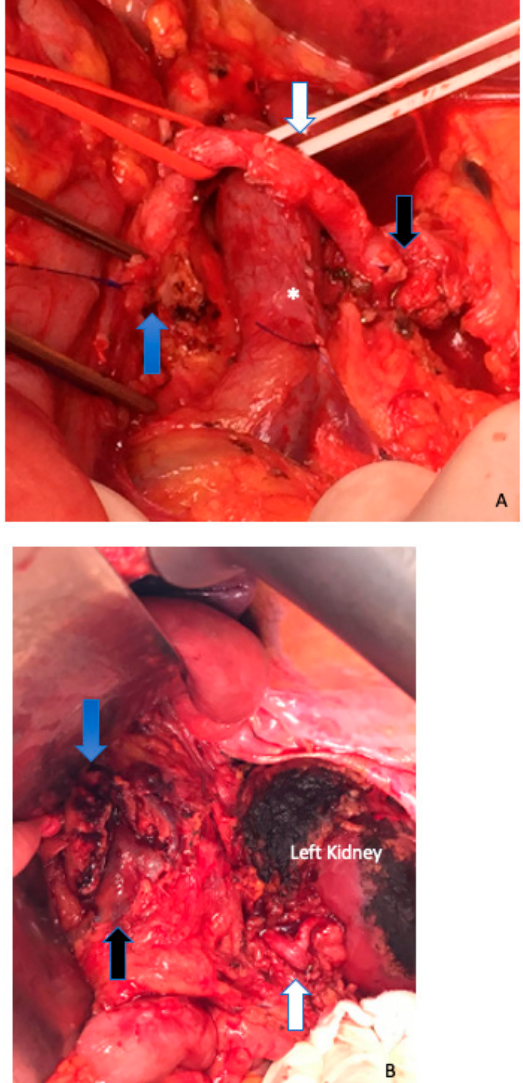
Figure 4. ( A ) Radical antegrade modular pancreatosplenectomy (RAMPS) proceeds in a right-to-left antegrade manner, with early parenchymal transection at the neck of the pancreas, close to the gastroduodenal artery (blue arrow) and early control of the splenic vessels (in its origin) (white arrow). The black arrow marks the common hepatic artery, and the asterisk shows a partial venous excision spleno–mesenteric confluence with direct closure (venorrhaphy). ( B ) Posterior RAMPS. The posterior magnitude of dissection was behind the left adrenal gland, including the Gerota fascia and the fat tissue around the left kidney. The left renal artery is shown with white arrow. Blue arrow shows the pancreas stump. Black arrow, superior mesenteric